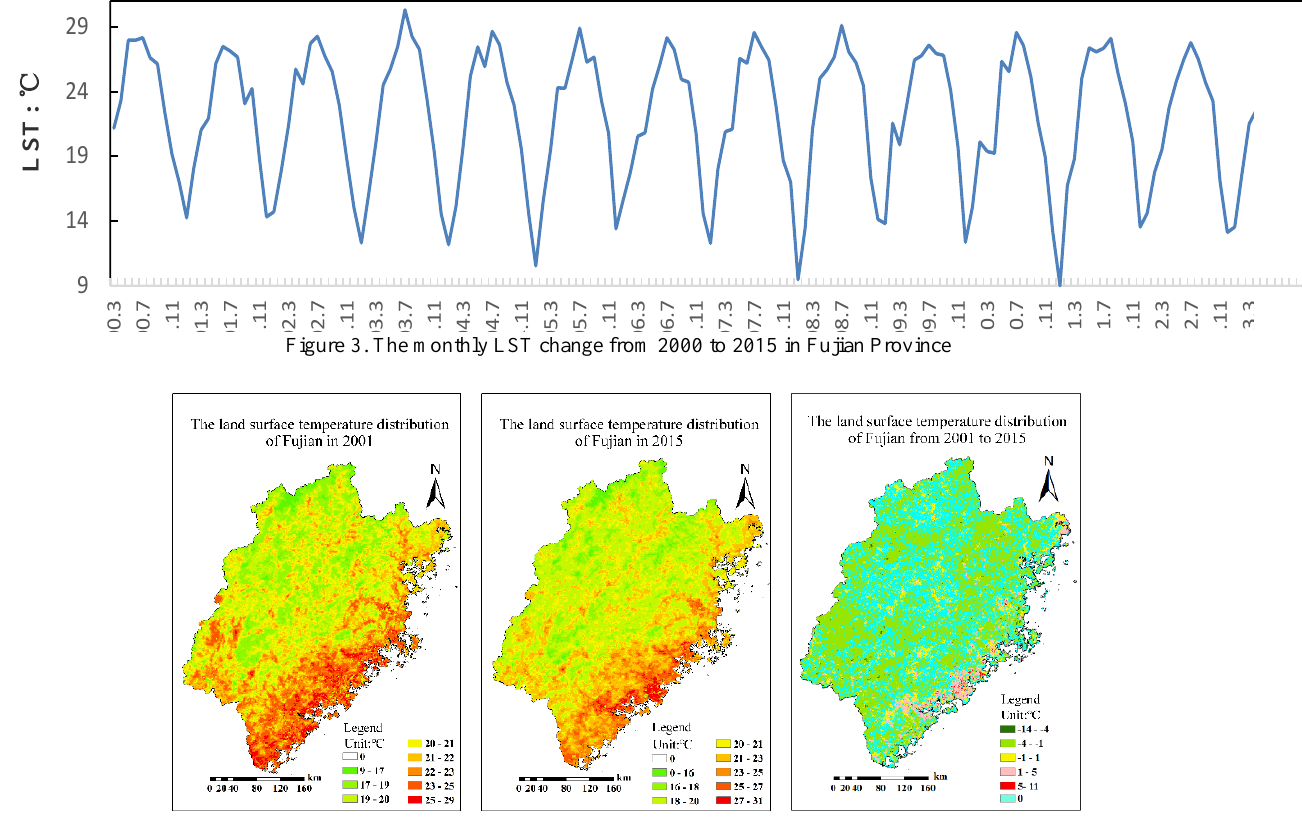
Figure 4. The annual LST spatial distribution in 2001 and 2015 and their differences in Fujian Province 5.